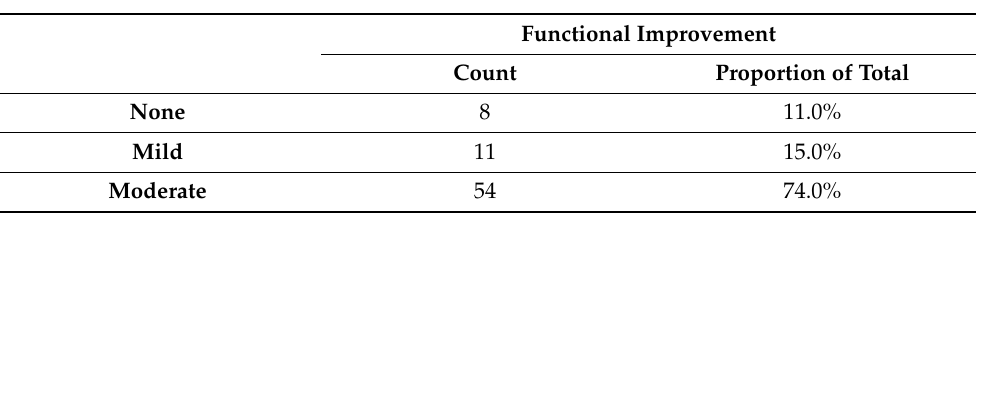
Table 4. Mean function-related assessment